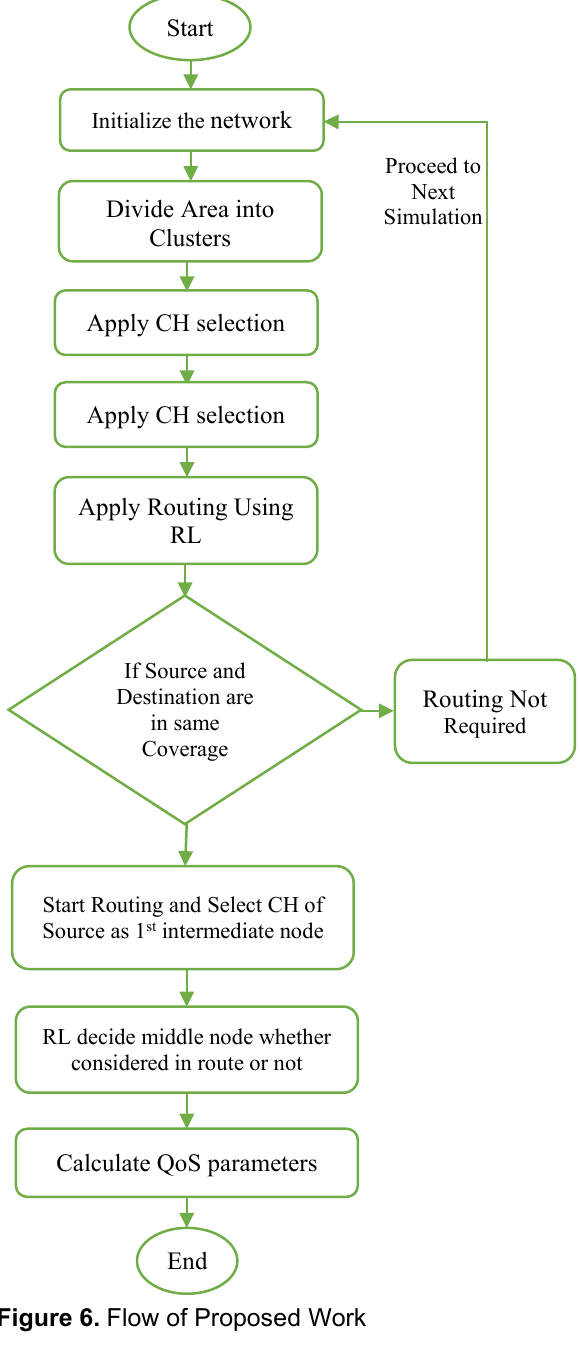
Figure 6. Flow of Proposed Work